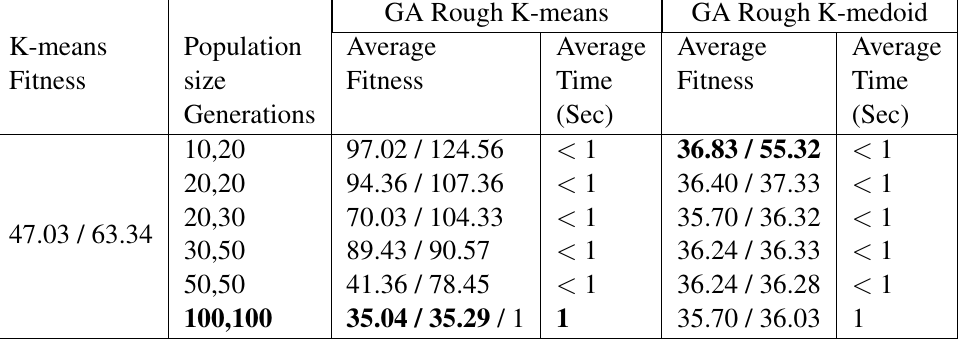
Table 2: Comparison of K-means, GA rough K-means and GA Rough K-medoid